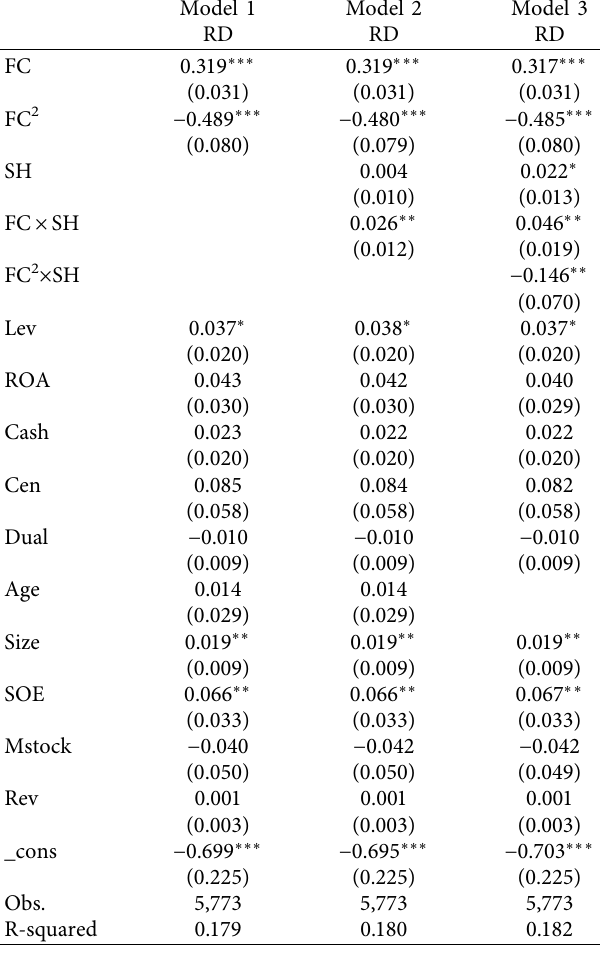
Table 4: Results of regression